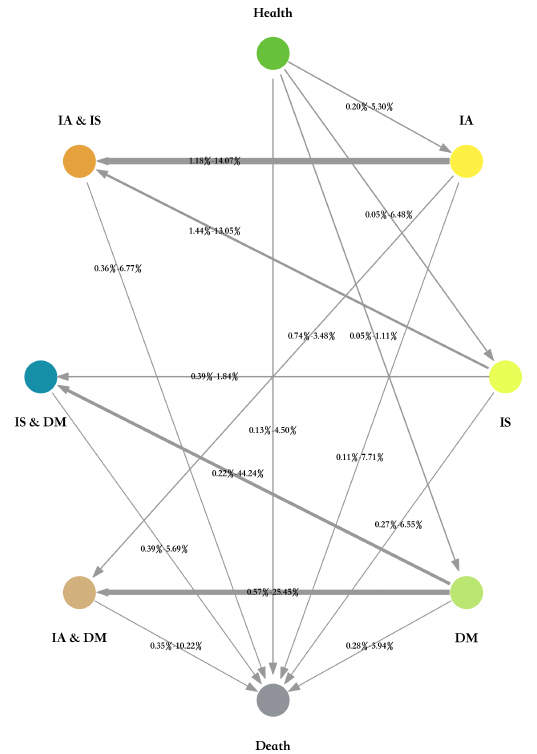
Figure 2. Transition probability graph of 2-year interval